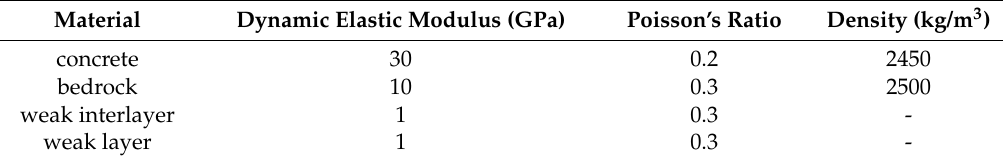
Table 2. Material